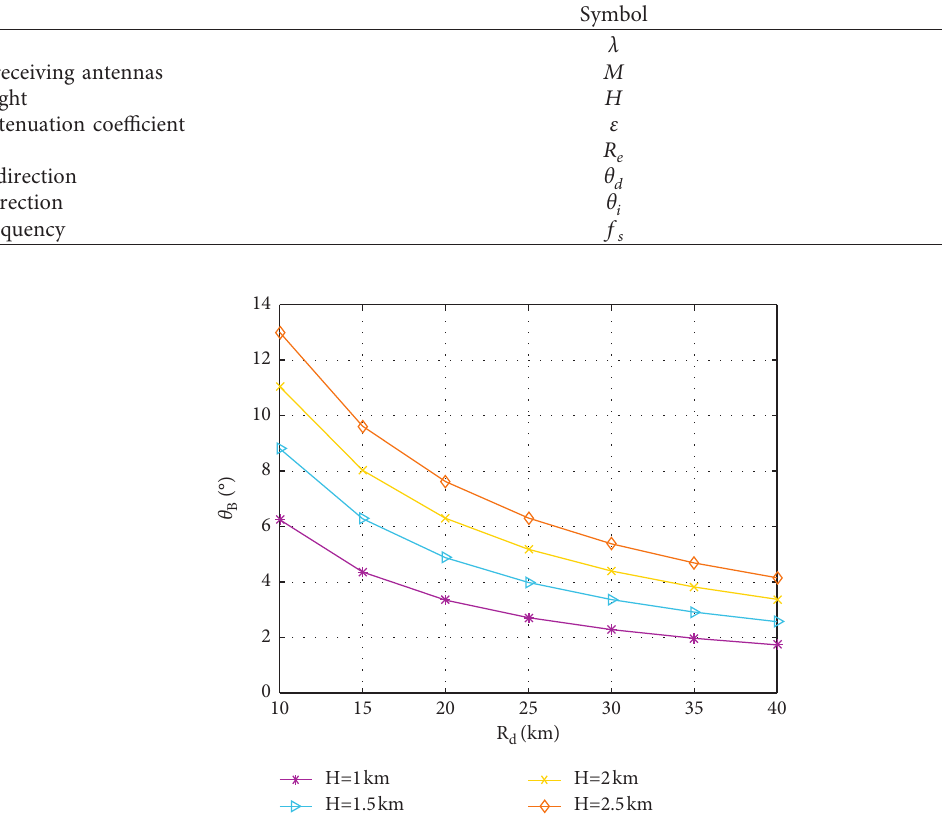
B and the DP range R d